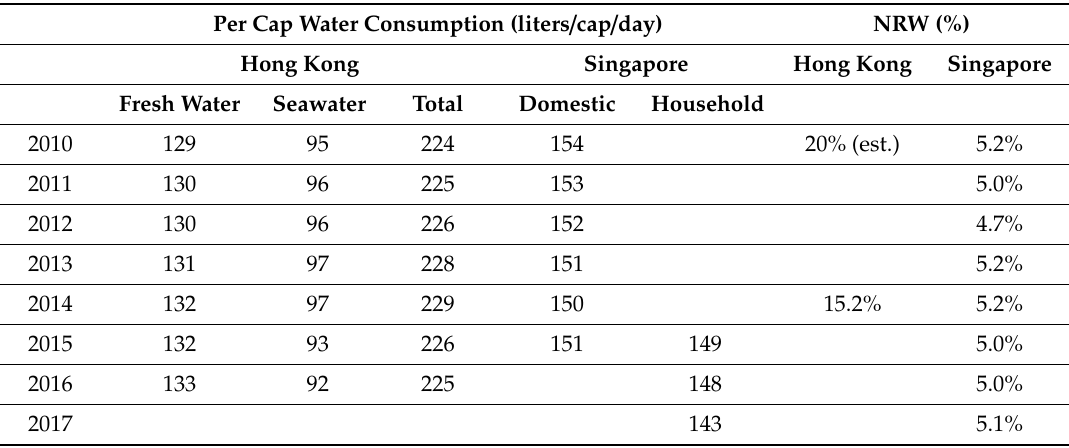
Table 2. Domestic / household water consumption (liters per capita per